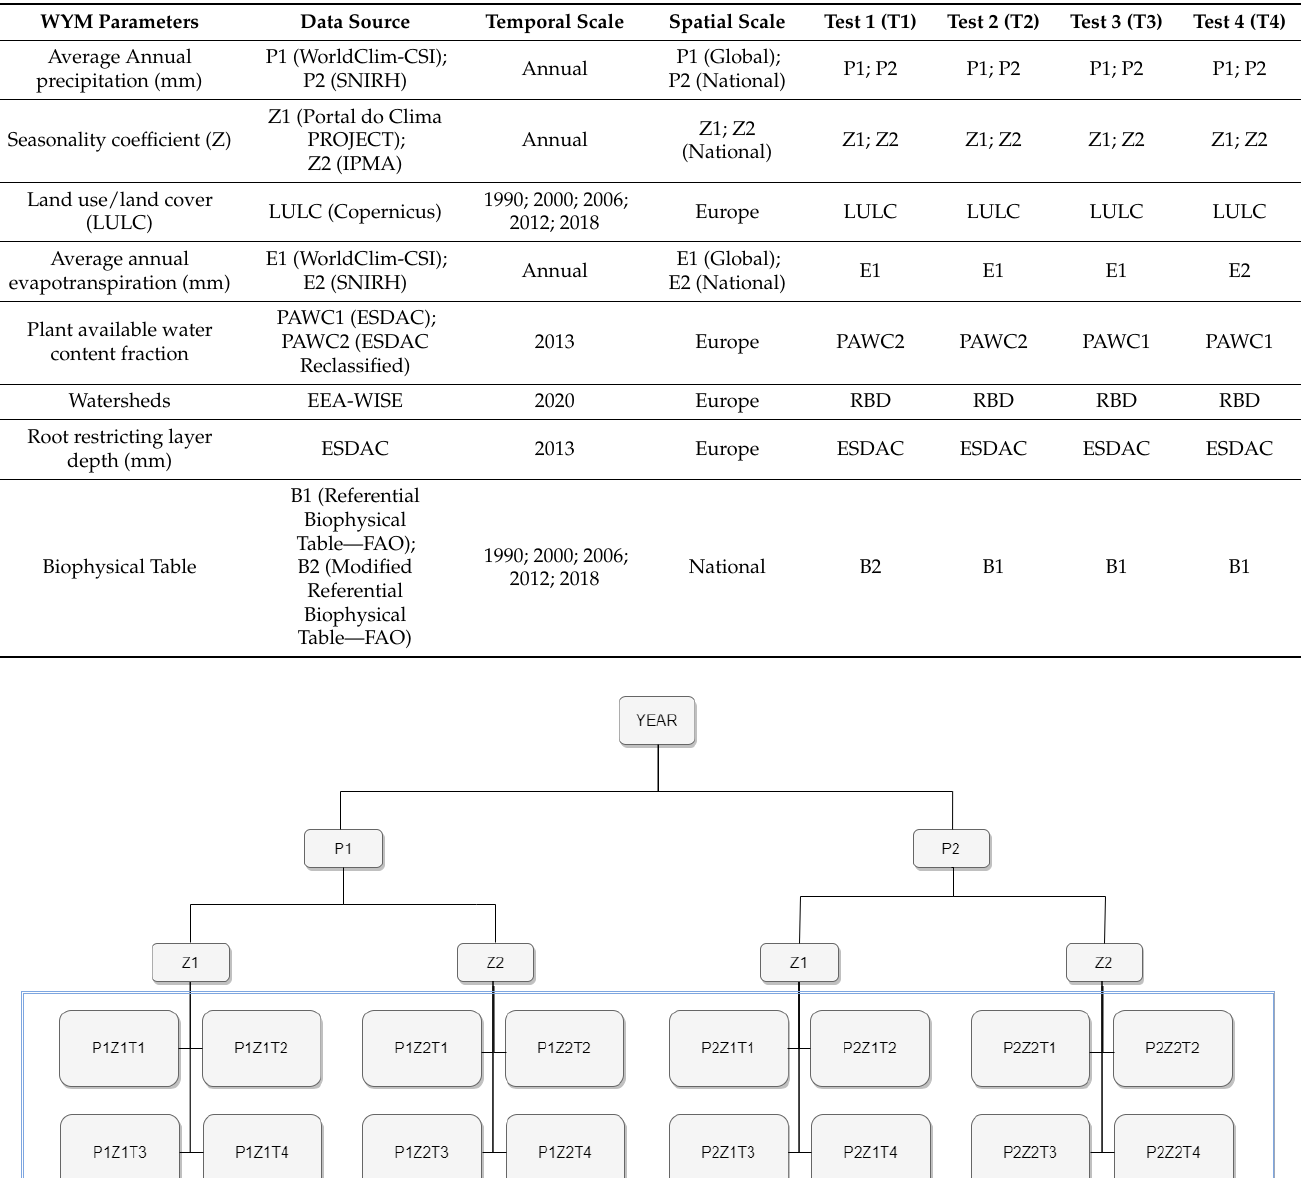
Table 3. Input data required in the WYM grouped by the 4 sensitivity analysis tests.